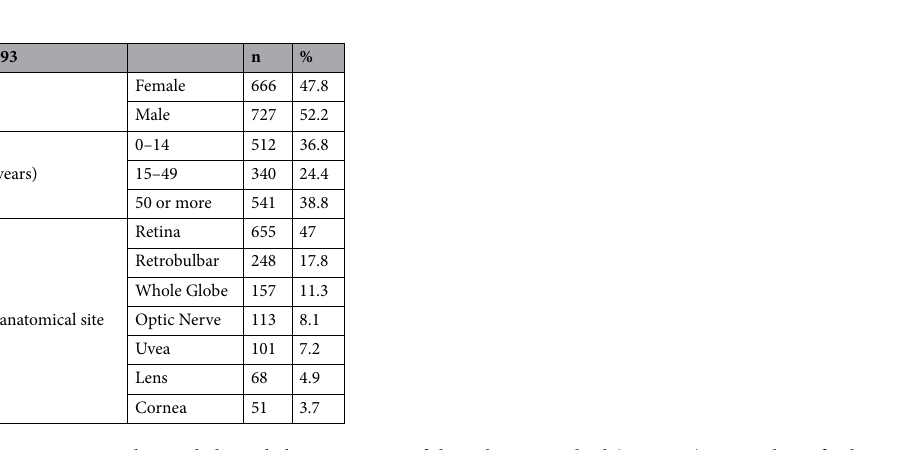
Figure 1. Flowchart of the subjects included in the study. BCVA best-corrected visual acuity, OU both eyes.